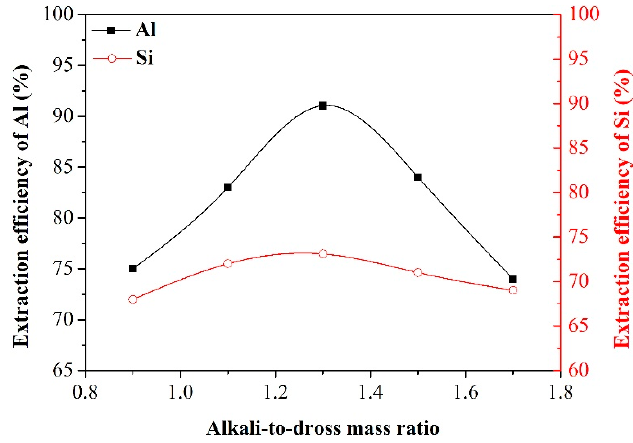
Figure 5. Effect of alkali-to-dross mass ratio on the extraction efficiency of Al and Si.